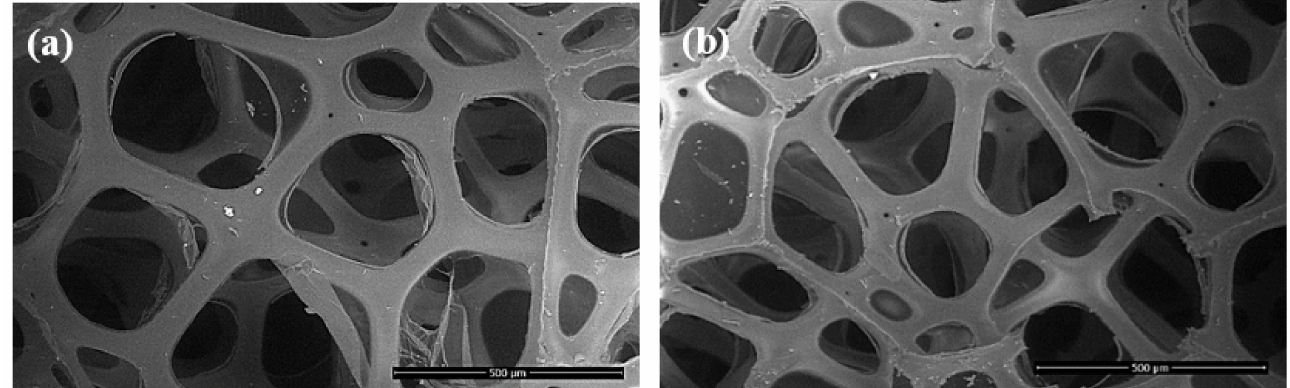
Figure 5. SEM images with the cellular structures of PU foams obtained with reference polyol ( a ) and 30% recycled polyol, using the formulation of EXP. 6 ( b